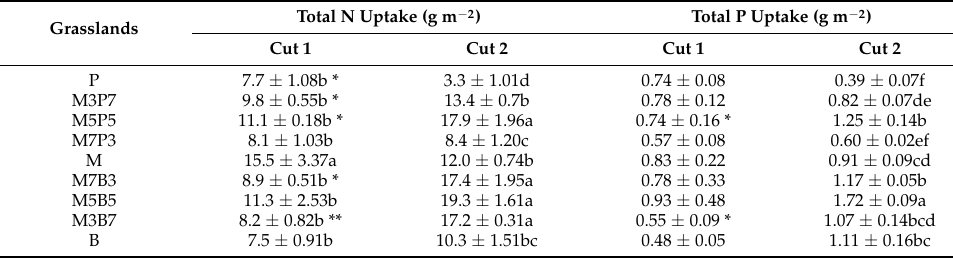
Table 4. Aboveground total N and P uptake of lucerne and grass in different grasslands.